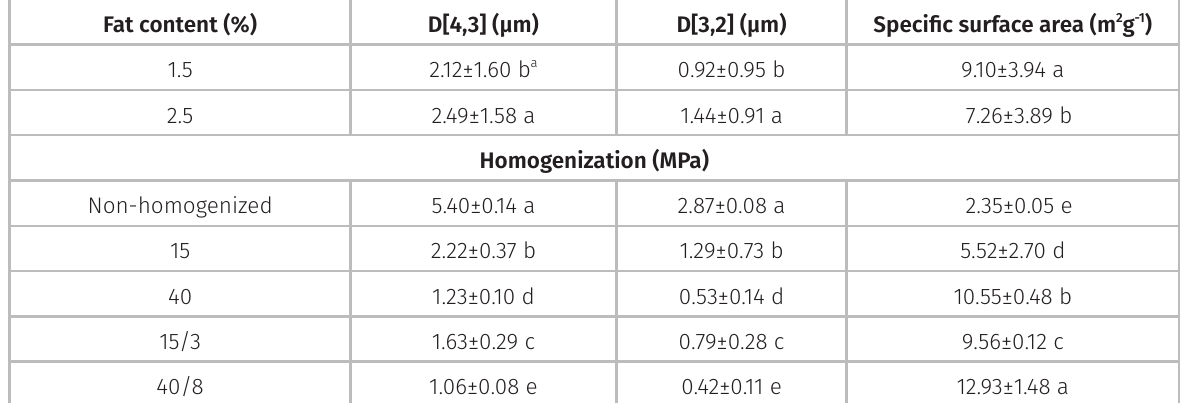
Table II. The effects of fat content and homogenization on the D[4,3], D[3,2] and specific surface area values of the ayran